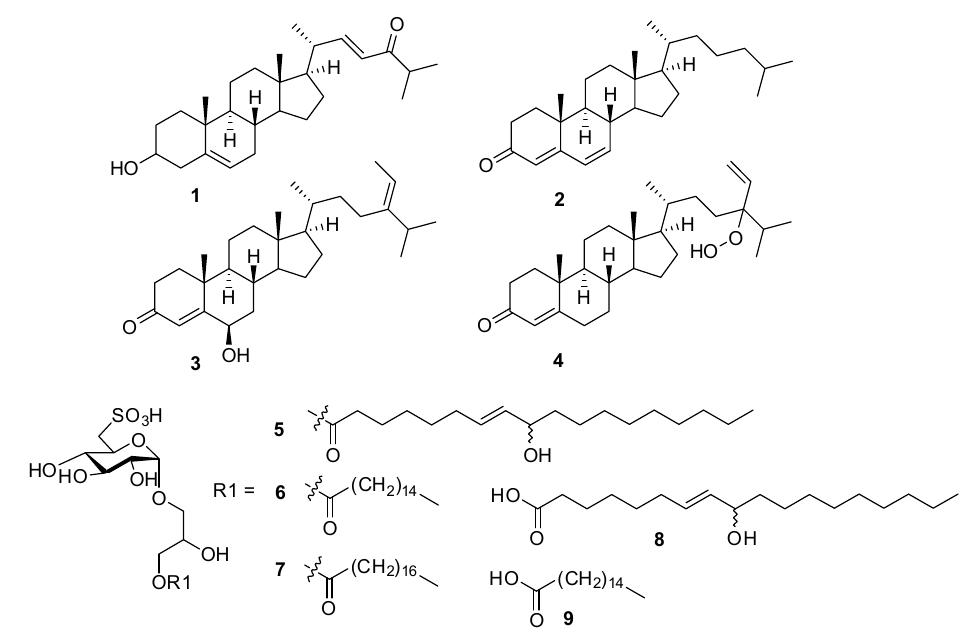
Figure 2. Structures of compounds 1 – 9 identified by NMR and LC-MS analysis from the M2 fraction of Turbinaria ornata extract (TOE).